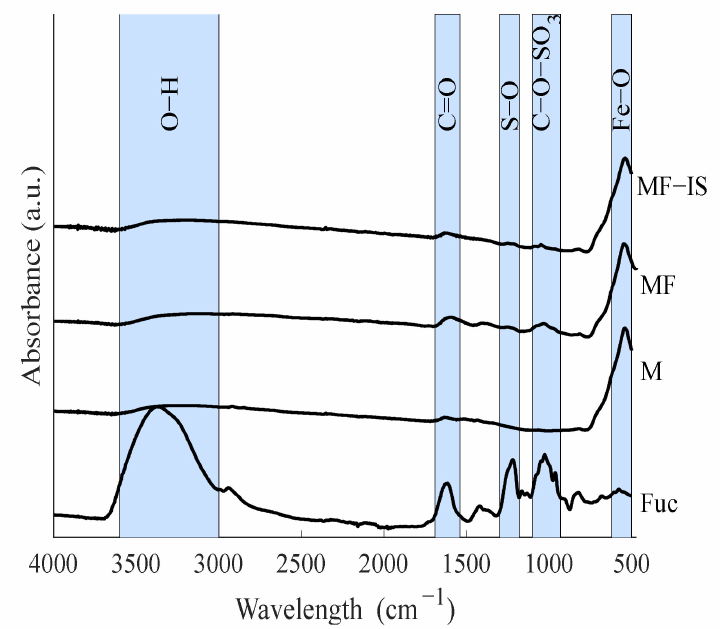
Figure 1. Normalized FTIR spectra of fucoidan (Fuc), magnetite (M), post-synthesis fucoidan-coated magnetite (MF), and in situ fucoidan-coated magnetite (MF − IS) samples. The magnetite (M) spectrum has a characteristic peak around 570 cm − 1 , which corre- sponds to the stretching vibrations of metal at the tetrahedral site of Fe-O, confirming the existence of the Fe 3 O 4 NP core [58]. This peak can be also observed in the spectra of both coated Fe 3 O 4 NP. The spectra relative to the magnetite coated with fucoidan after synthesis and coated in situ exhibit peaks around 1030 and 1224 cm − 1 . The peak at 1030 cm − 1 corre- sponds to symmetric C-O vibration associated with C-O-SO 3 and the peak at 1224 cm − 1 is assigned as S=O stretching vibration, which indicates the presence of esterified